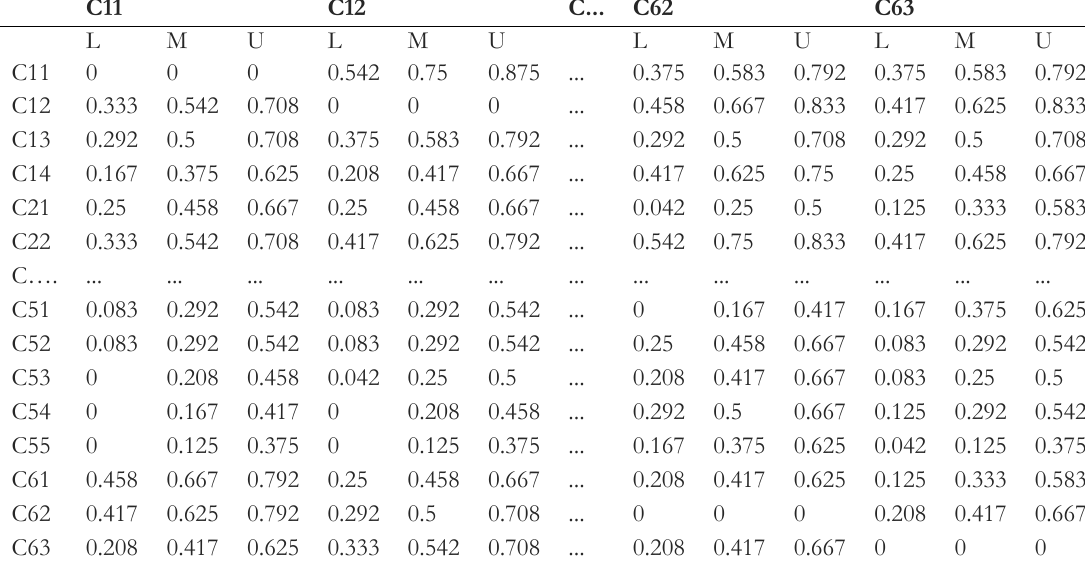
Table 5. Direct fuzzy relations matrix between